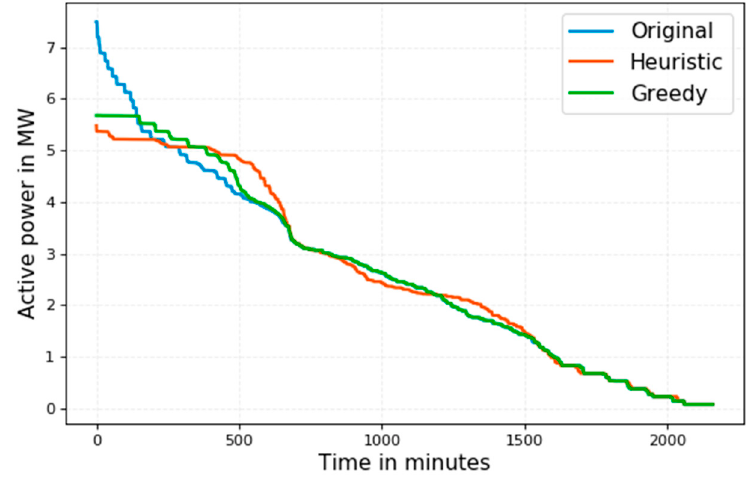
Figure 10. Load distribution from the three compared algorithms during the simulated time.